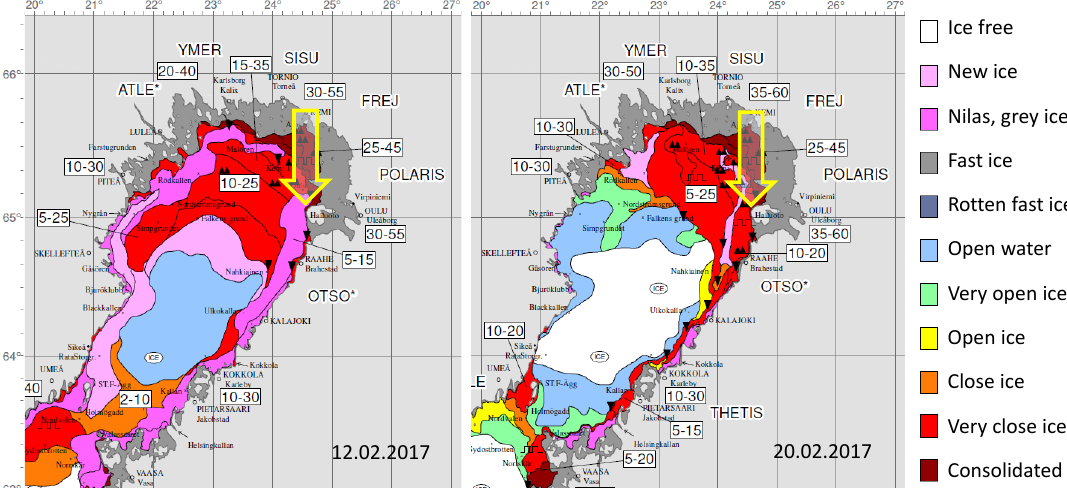
Figure 5. Examples of sea ice charts: maximum extent during the campaign on 12 February 2017 ( left panel ) and minimum on 20 February 2017 ( right panel ). The ice type is color coded; the numbers in the white boxes indicate the ice thickness in cm. The charts were provided by the Finnish Meteorological Institute on an operational basis (http://en.ilmatieteenlaitos.fi/ice-conditions). The location of the experiment site is indicated by the yellow